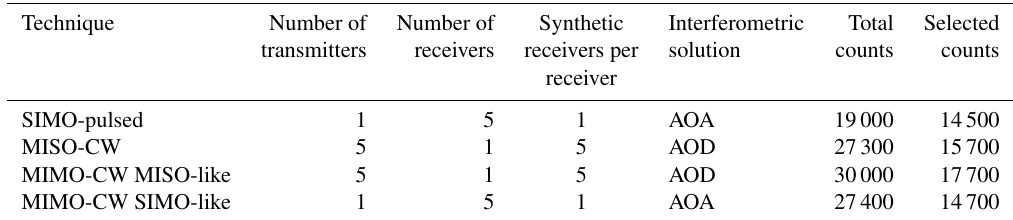
Table 2. Summary of SMR implementations. Only detections with zenith angle with respect to the reference that are smaller than 60 ◦ are included under “selected